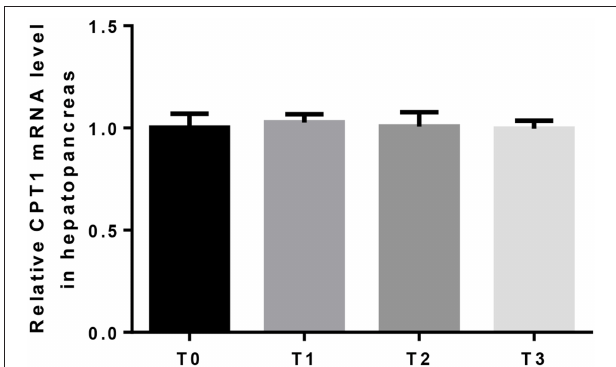
FIGURE 6 | The relative expression of CPT1 mRNA in the hepatopancreas. The letters indicate the results of multiple range test, no letter indicated no significant differences ( P >